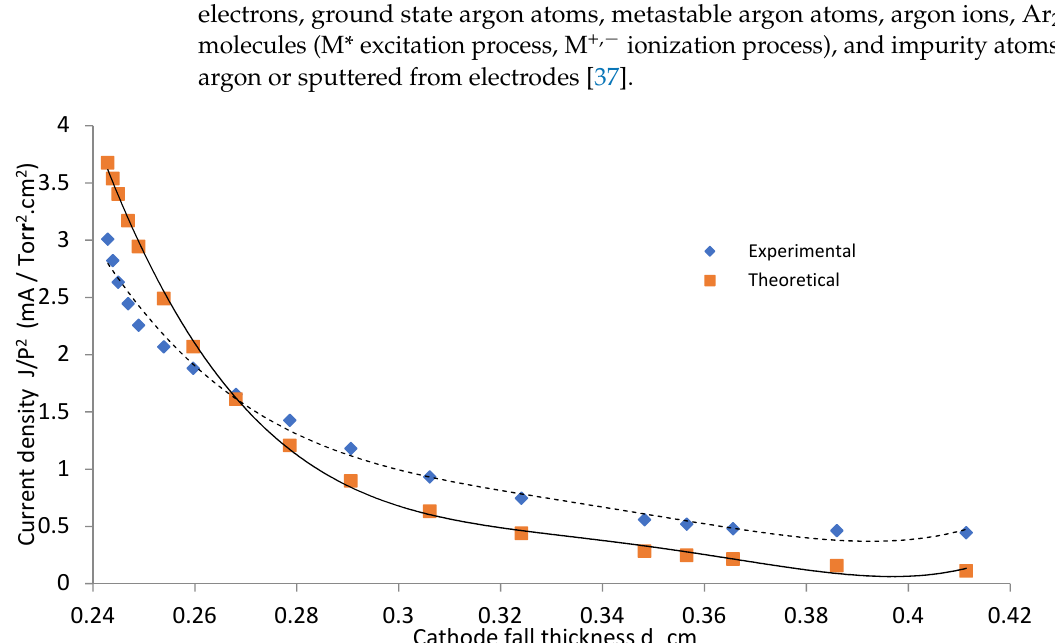
Figure 8. Current density as a function of the cathode fall thickness for OMSE with applied pressure of 1 mTorr.